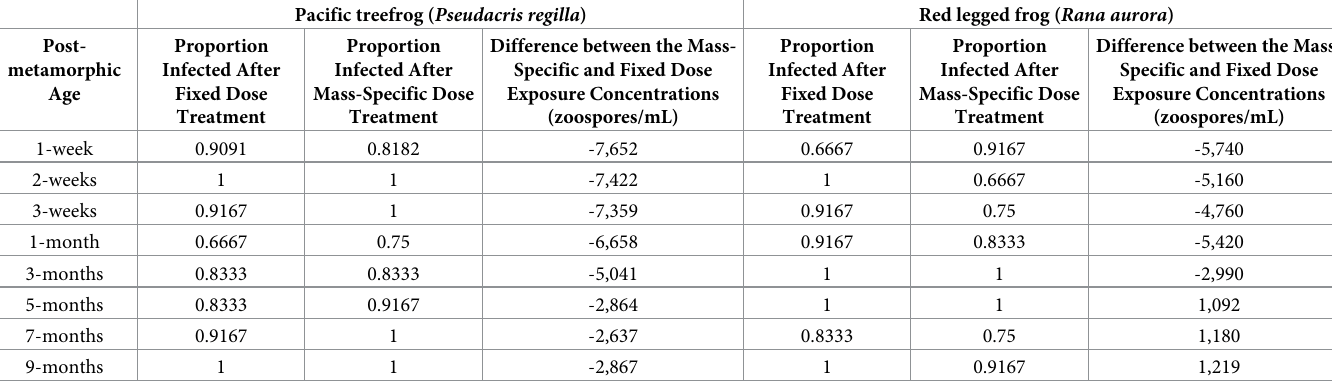
Table 1. Proportion infected individuals in each of the Bd-exposure treatments. Pacific treefrog ( Pseudacris regilla ) Red legged frog ( Rana aurora